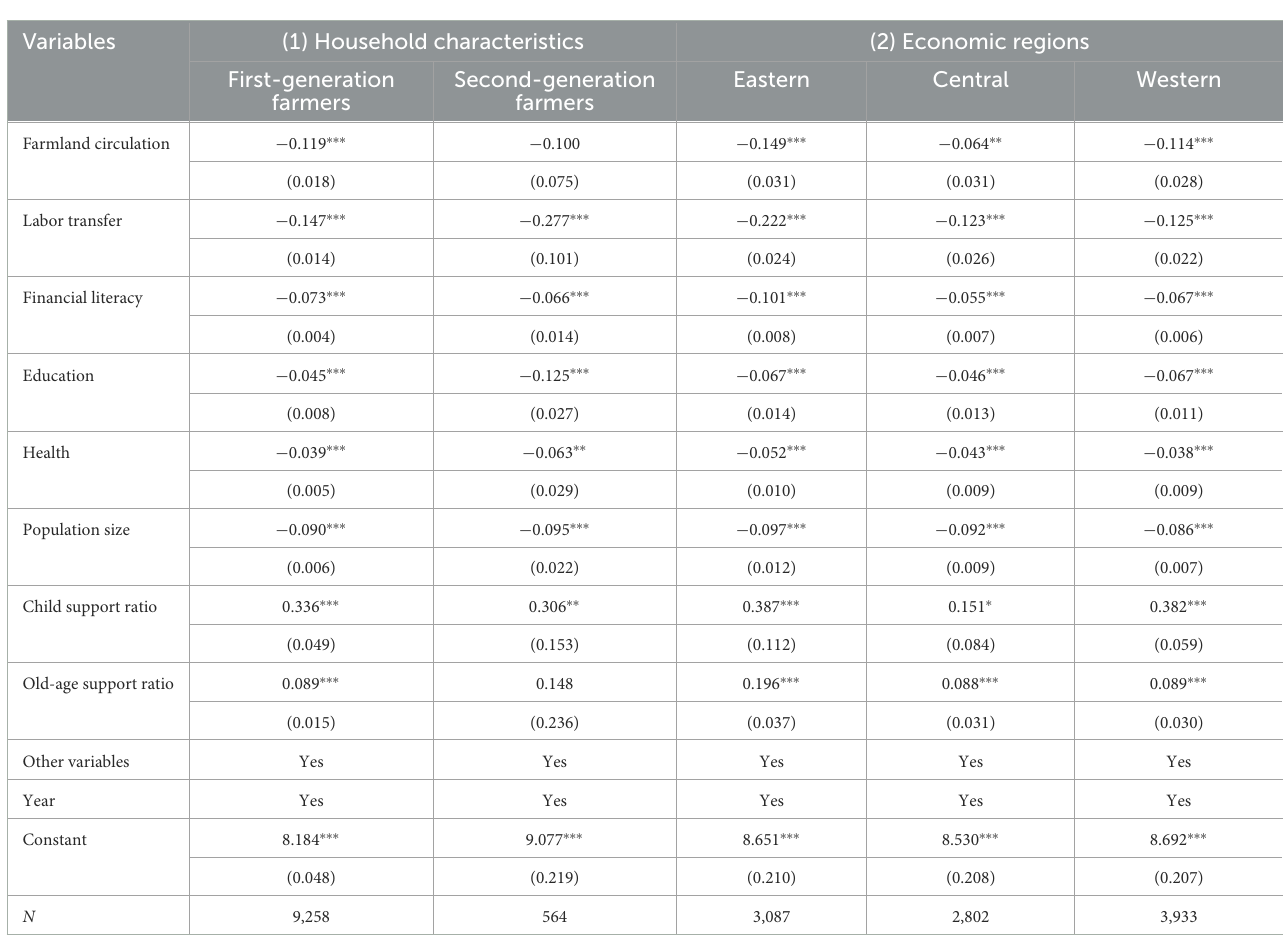
TABLE 9 Heterogeneity regression results of farmland circulation on financial vulnerability.